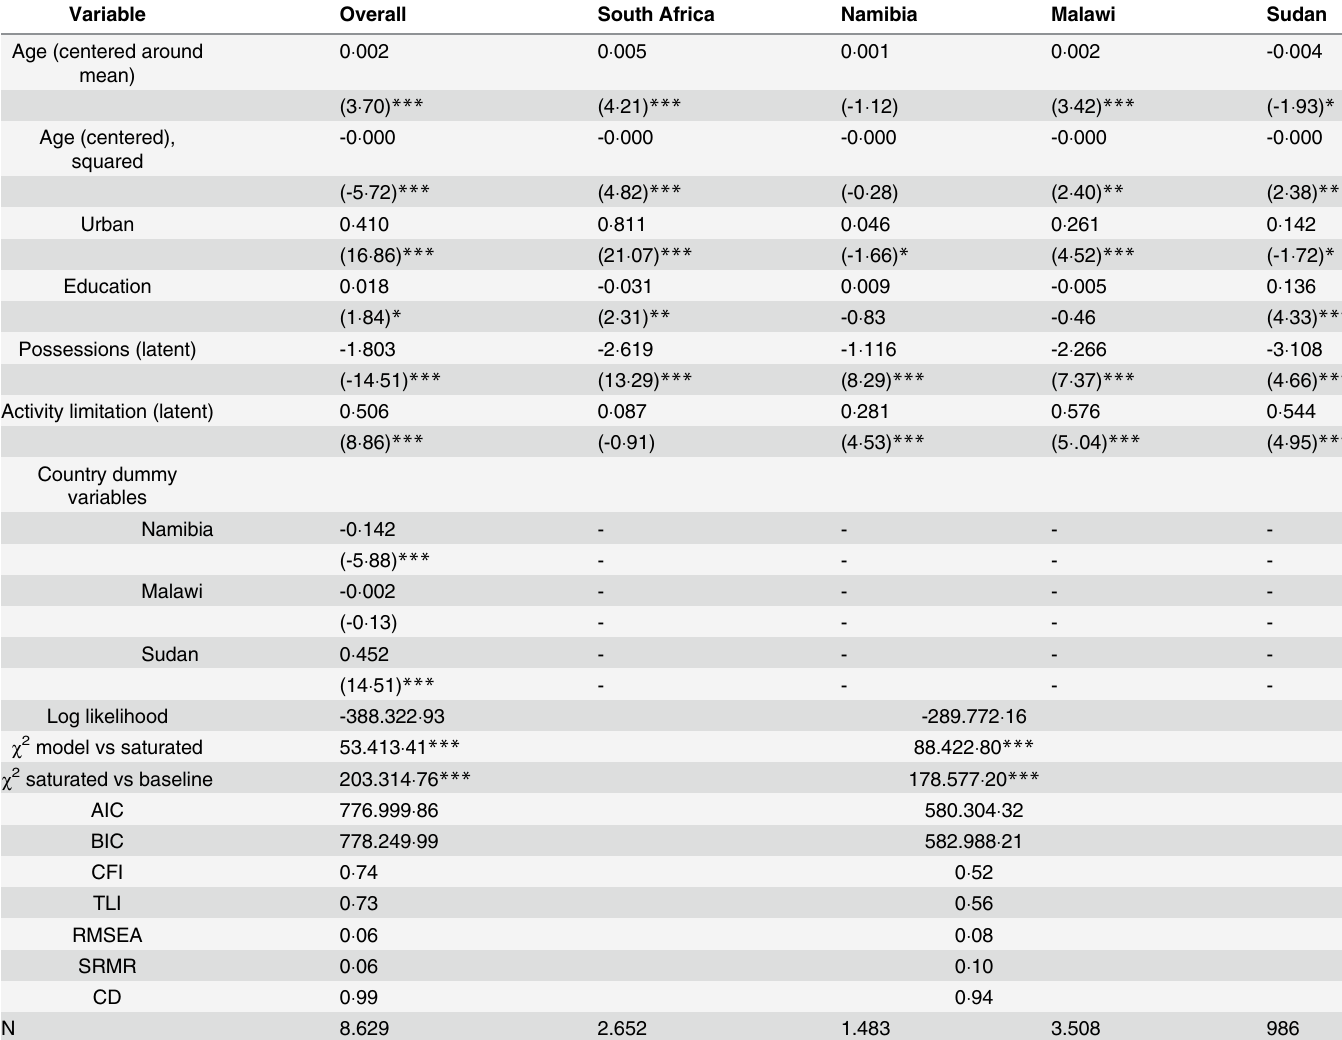
Table 3. SEM structural model of barriers to health services, overall and by